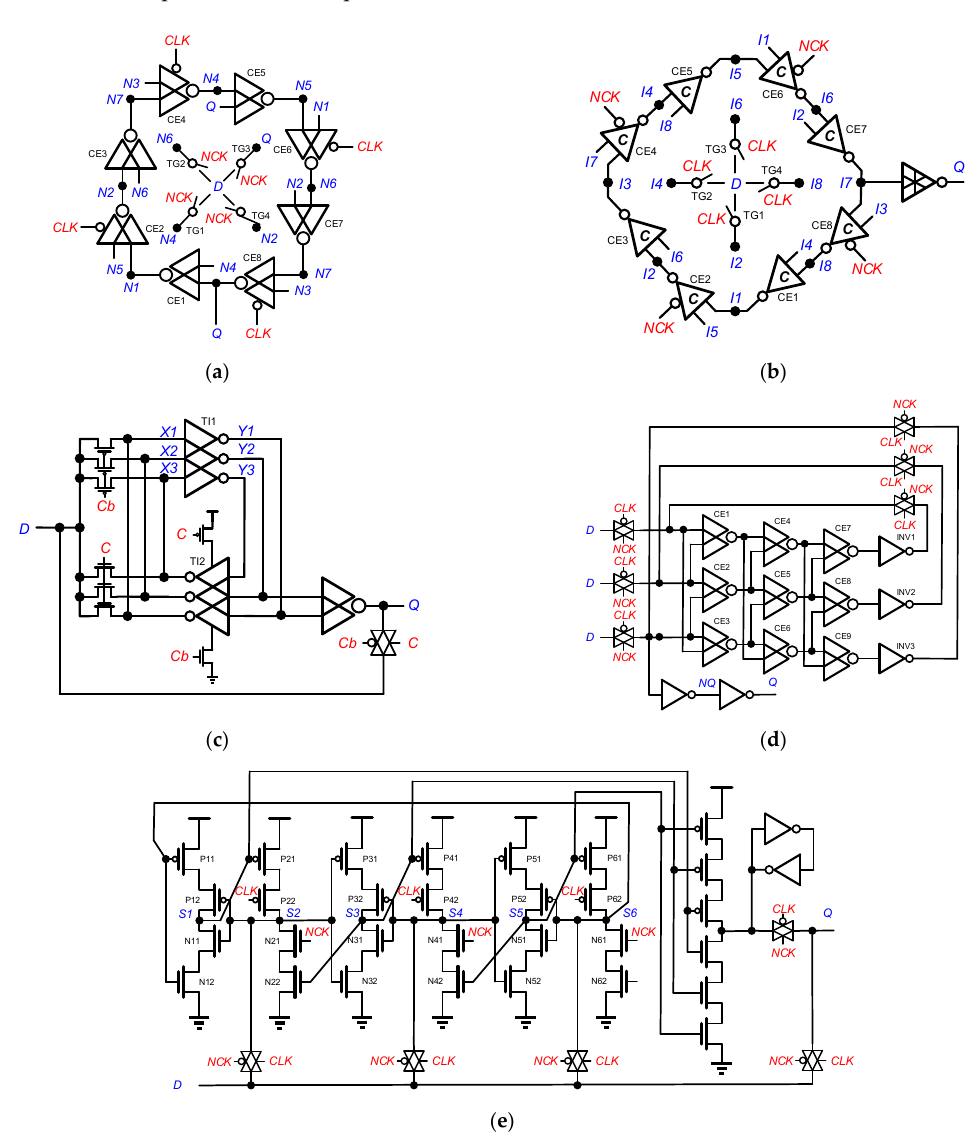
Figure 2. Schematics of the reviewed latch designs: ( a ) DNURHL; ( b ) DNUTPF; ( c ) SEDUL; ( d ) NTHLTCH; ( e ) LSEDUT.